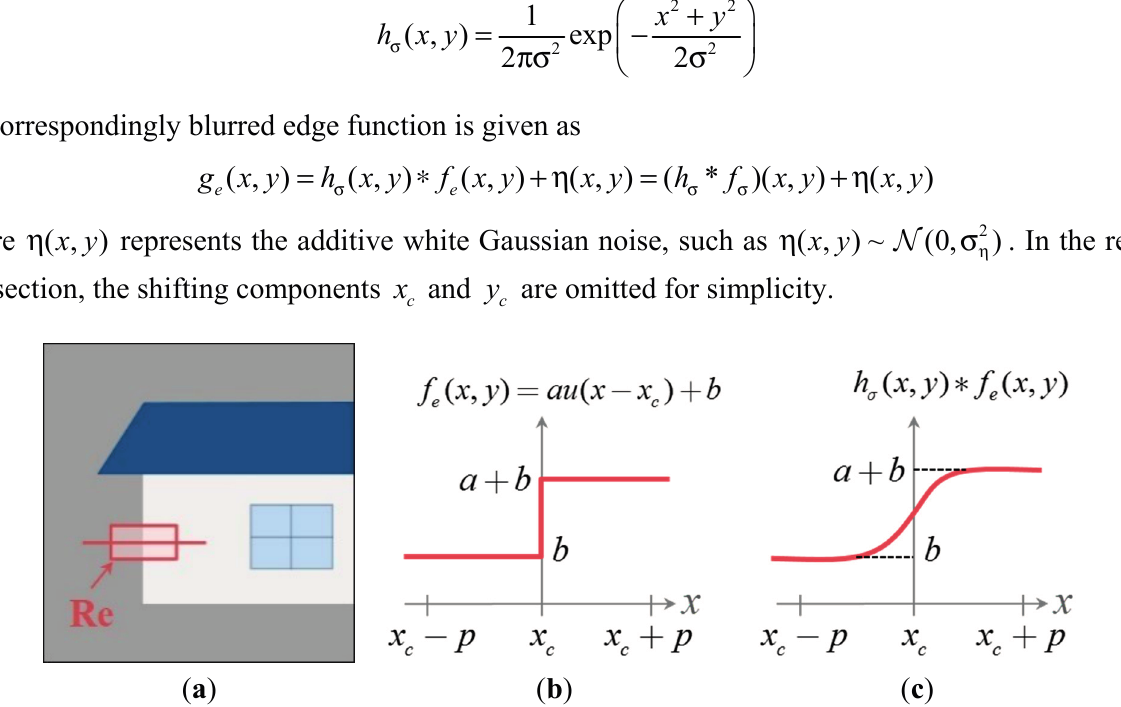
Figure 5. ( a ) A (2 1) (2 1) p p + × + region centered at ( , ) only a single edge; ( b ) the ideal edge function along the horizontal line in convolution of the ideal edge function with a Gaussian blurring